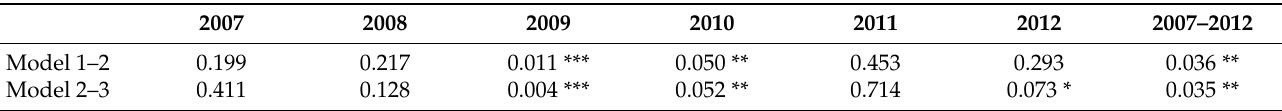
Table 6. Kruskal–Wallis rank sum test of the performance differences within/between Models